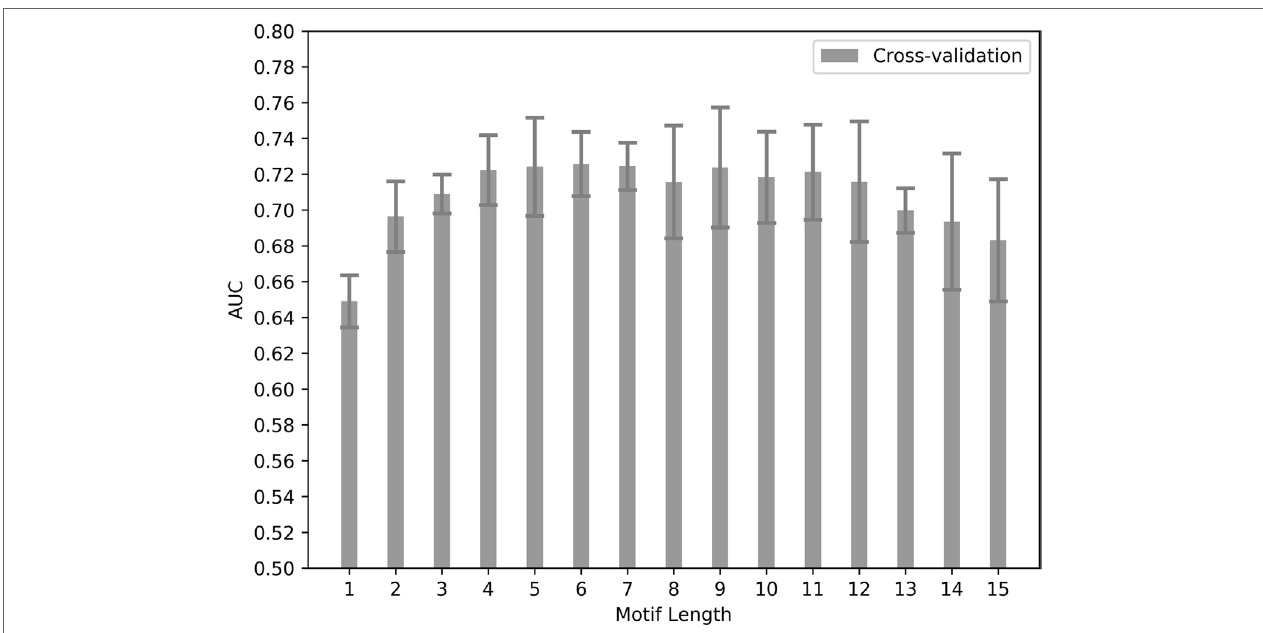
FigUre 1 | Predictive performances for different motif lengths. Bars show cross-validation performance for the training dataset. Area under the ROC curve (AUC) values are shown for each artificial neural network training done by choosing different sequence lengths to define a preferred sequence motif within a 15-mer peptide. Error bars show SD of the five cross-validation